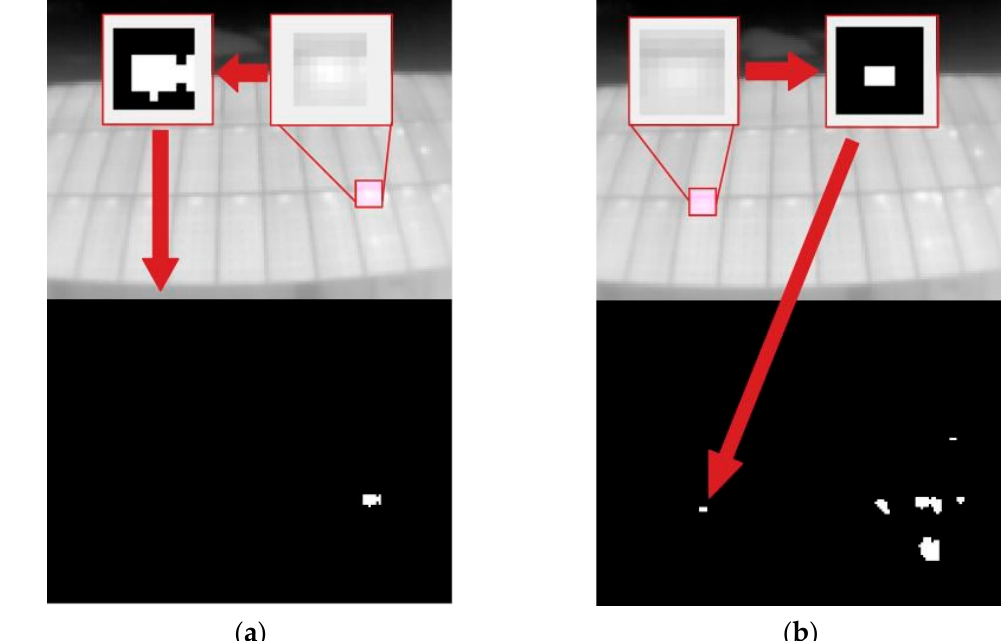
Figure 9. Binarization and storage of the neighboring pixel window. ( a ) Iteration 1; ( b ) Iteration